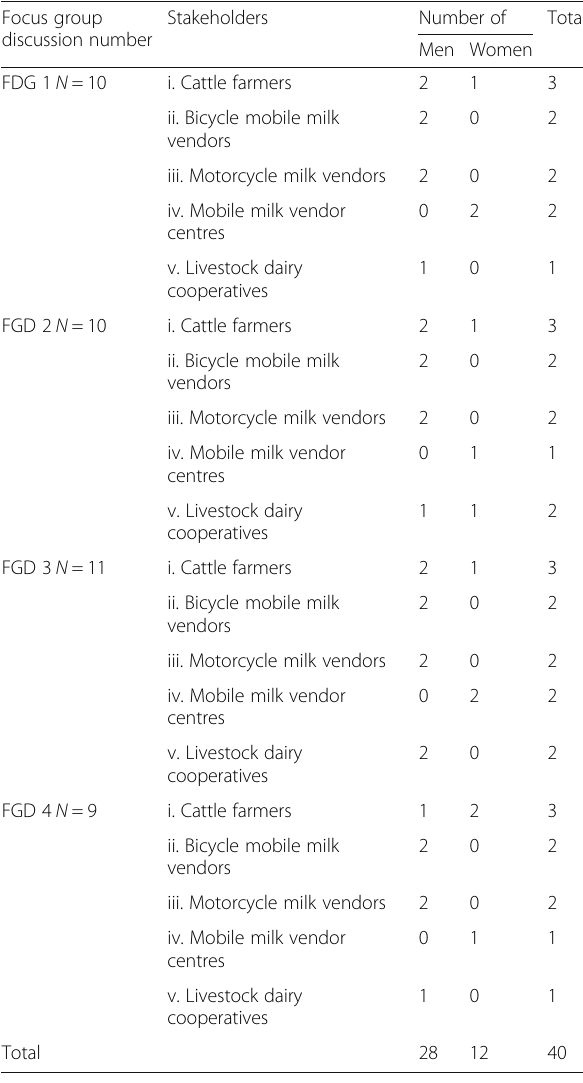
Table 1 Composition of the different focus group discussions from Nakasongola